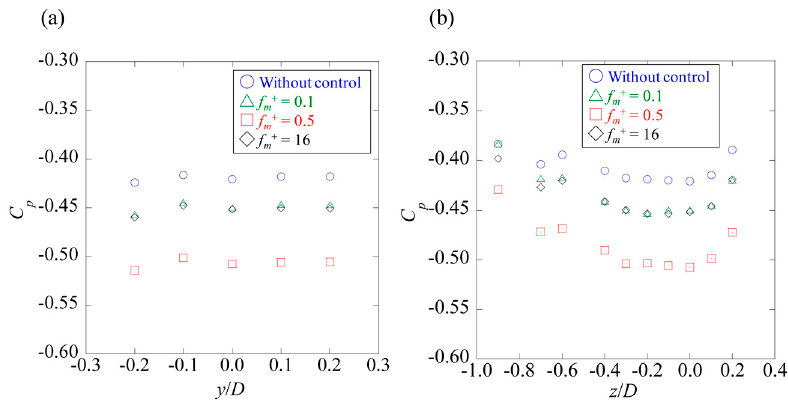
Figure 16. C p as a function of ( a ) y / D at z / D = 0.0, and ( b ) z / D at y / D = 0.0.